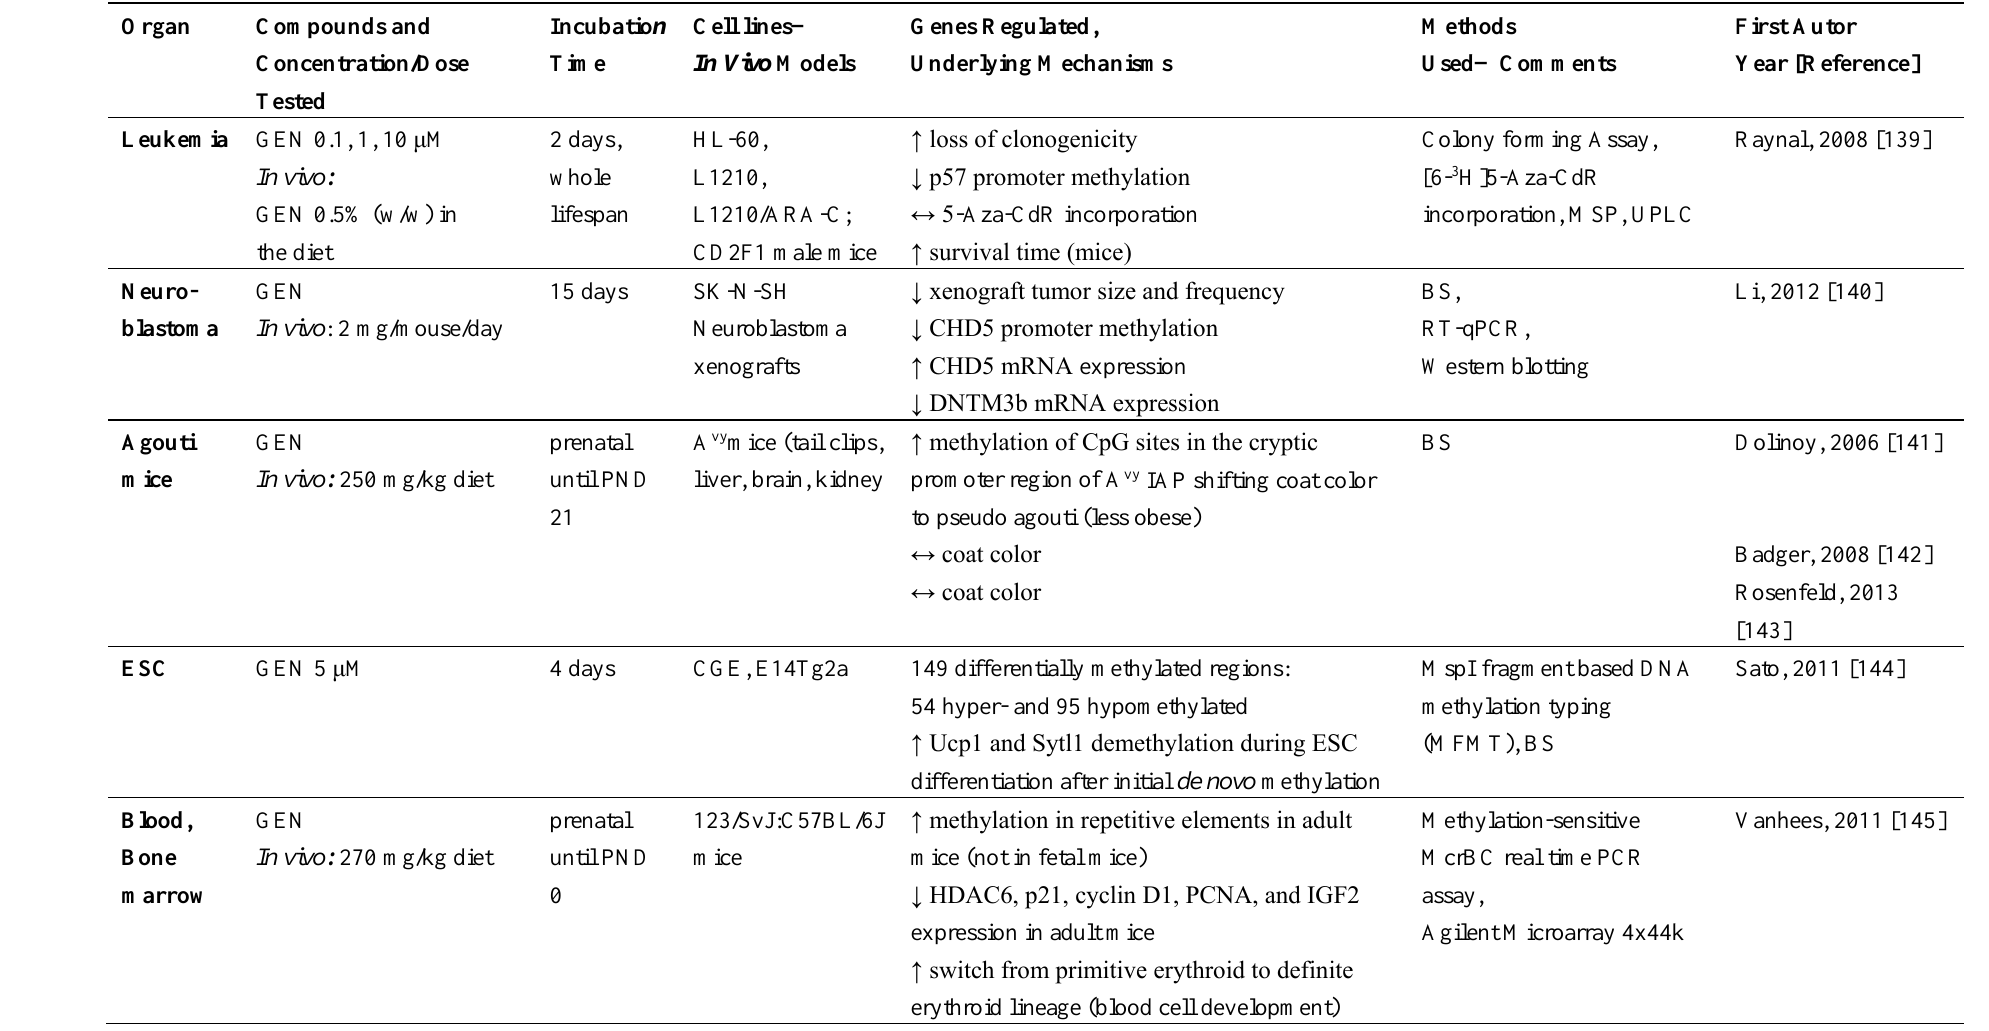
Table 5 . Soy isoflavones targeting epigenetic mechanisms in further in vivo